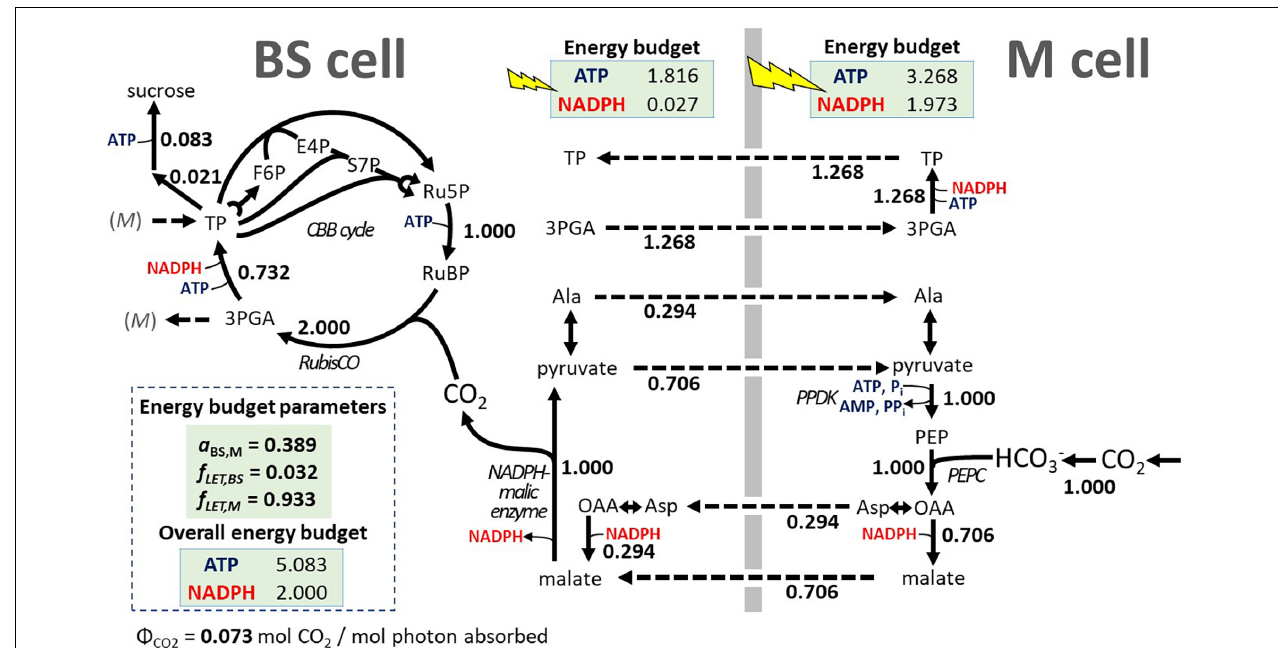
FIGURE 3 | Effect of energy budget parameters on the C 4 photosynthesis scheme in iTJC1414x4 . Flux values are shown relative to uptake of one unit CO 2 . The shown sorghum-specific parameters for light flux distribution (energy budget parameters) were derived from a cell-type-specific electron transport model for C 4 plants by Yin and Struik (2018) and cause BSC- and MC-specific production of ATP and NADPH by photosynthetic light reactions to balance the photosynthetic supplies and metabolic demands. Note that at the PPDK step, AMP needs to be recycled, leading to a net demand of 2 mol ATP for PEP regeneration. Flux values are obtained from the primary FBA solution using flux projections (see section “Materials and Methods” and Supplementary Table 7 , model scenario 3). 3PGA, 3-phosphoglycerate; a BS , M , BS:M ratio in light absorption; Ala, alanine; Asp, aspartate; BS cell, bundle sheath cell; CBB, Calvin–Benson–Bassham; E4P, D-erythrose-4-phosphate; F6P, D-fructose-6-phosphate; f LET , BS , fraction of BS cell absorbed irradiance that is used for linear electron transport; f LET , M , fraction of M cell absorbed irradiance that is used for linear electron transport; M cell, mesophyll cell; OAA, oxaloacetate; PEP, phosphoenolpyruvate; PPDK, pyruvate phosphate dikinase; Ru5P, D-ribose-5-phosphate; RubisCO, ribulose 1,5 bisphosphate carboxylase oxygenase; RuBP, D-ribulose-1,5-bisphosphate; S7P, D-sedoheptulose-7-phosphate; TP, triose phosphates; (cid:56) CO 2 , absorbed quantum yield for CO 2 uptake (mol CO 2 / mol